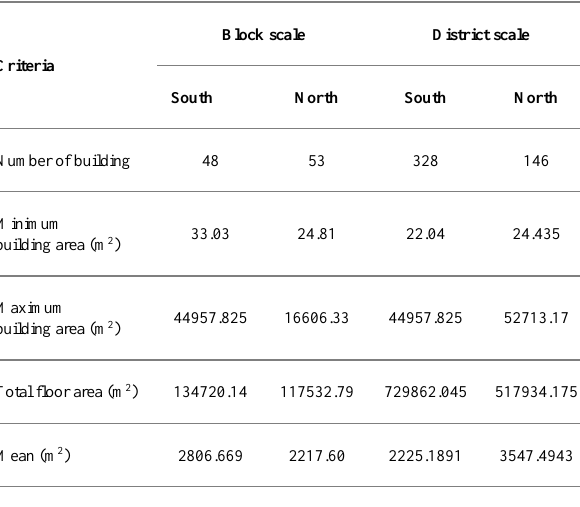
Table 9. Urban space usage configuration of the study area considered separately by block-scale and district-scale from both sides of the major street